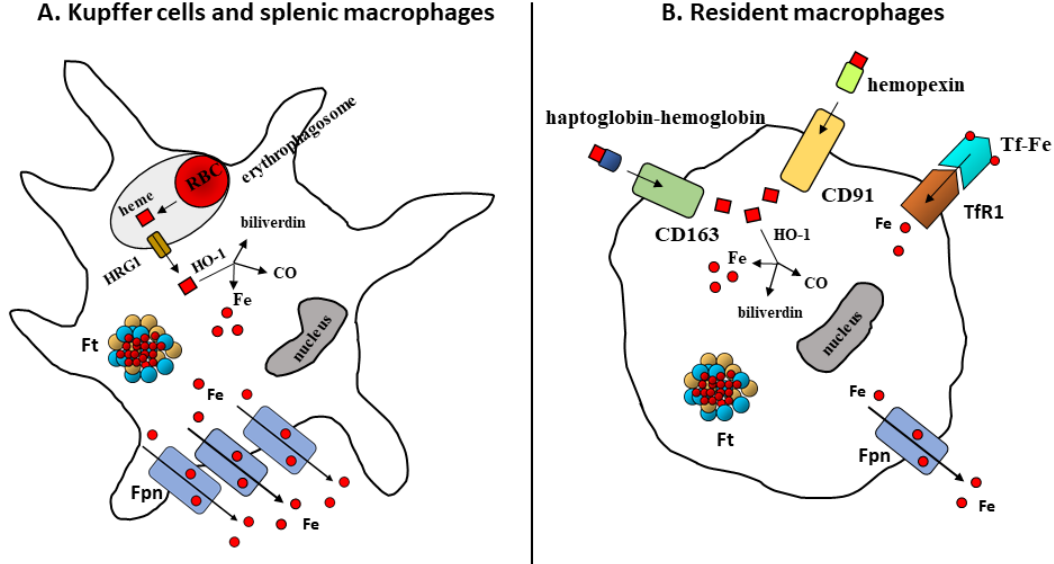
Figure 1. Iron trafficking in macrophages. ( A ) Macrophages specialized in erythrophagocytosis, for example in the spleen and liver (Kupffer cells), mainly acquire heme iron derived from the ingestion and degradation of red blood cells (RBC). Following erythrocyte internalization, heme derived from hemoglobin and exported from phagolysosomes to the cytosol by HRG1 is catabolized by heme oxygenase (HO-1); the resulting iron is mainly exported by ferroportin (Fpn) or stored in ferritin (Ft). ( B ) Other types of macrophages can obtain iron through several alternative mechanisms. These resident macrophages process a lower amount of iron and acquire both heme iron through the LRP1/CD9 and CD163 receptors, which scavenge hemopexin and haptoglobin, respectively, and transferrin-bound iron via transferrin receptors (TfR1). Since an average macrophage ingests at least one red cell/day [15], erythrophagocyto- sis represents the major mechanism of iron uptake; however, macrophages can use several different routes to obtain iron (Figure 1). It is possible that these alternative pathways play a more important role in the variety of macrophages that do not have